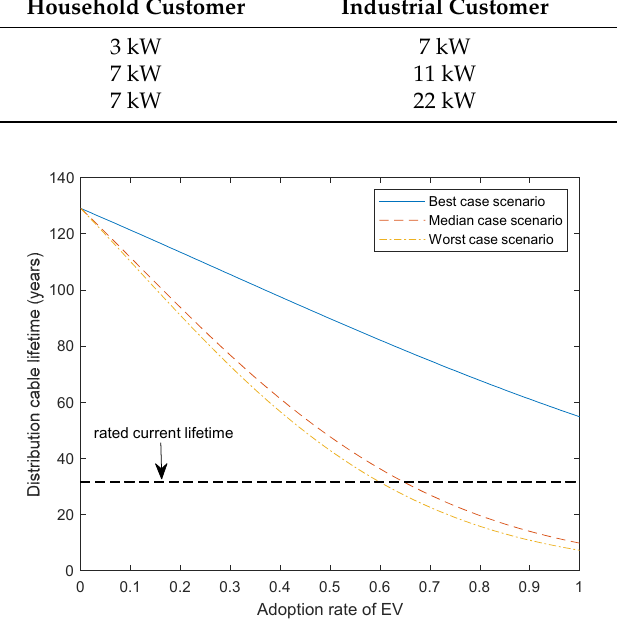
Figure 7. The lifetime of the distribution cable with EV adoption rate.